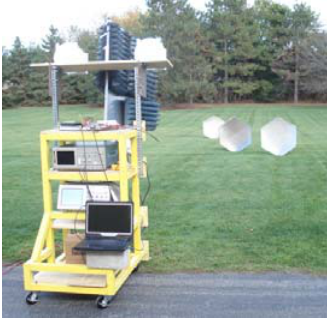
Figure 10. Field measurement setup for multimodal